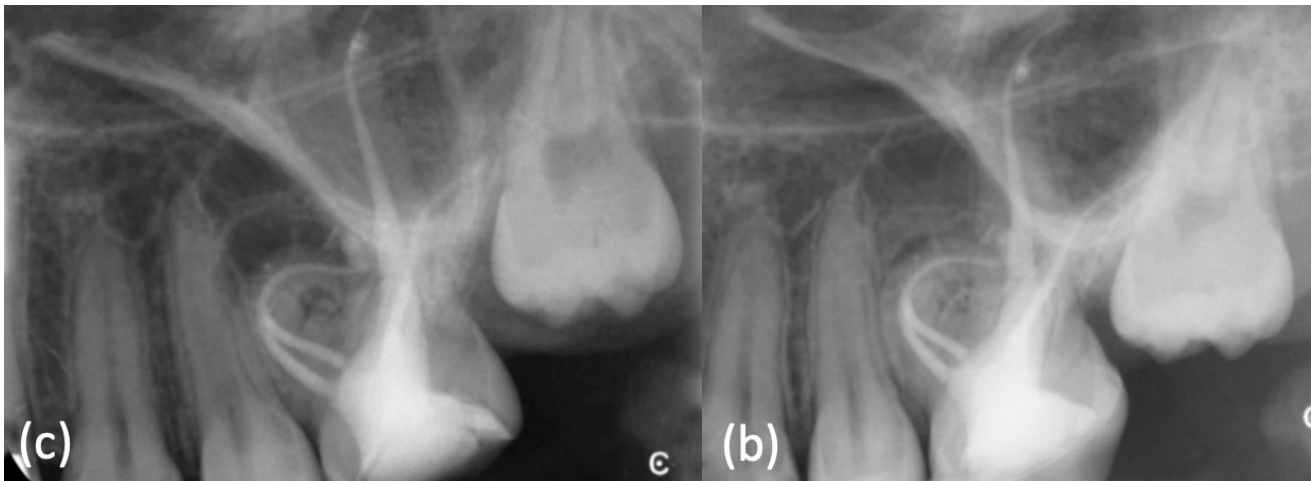
Figure 9. ( a ) Post-operative X-ray was taken. ( b ) At 6 months review the periapical X-ray showed a smaller radiolucent area around the mesial buccal root.